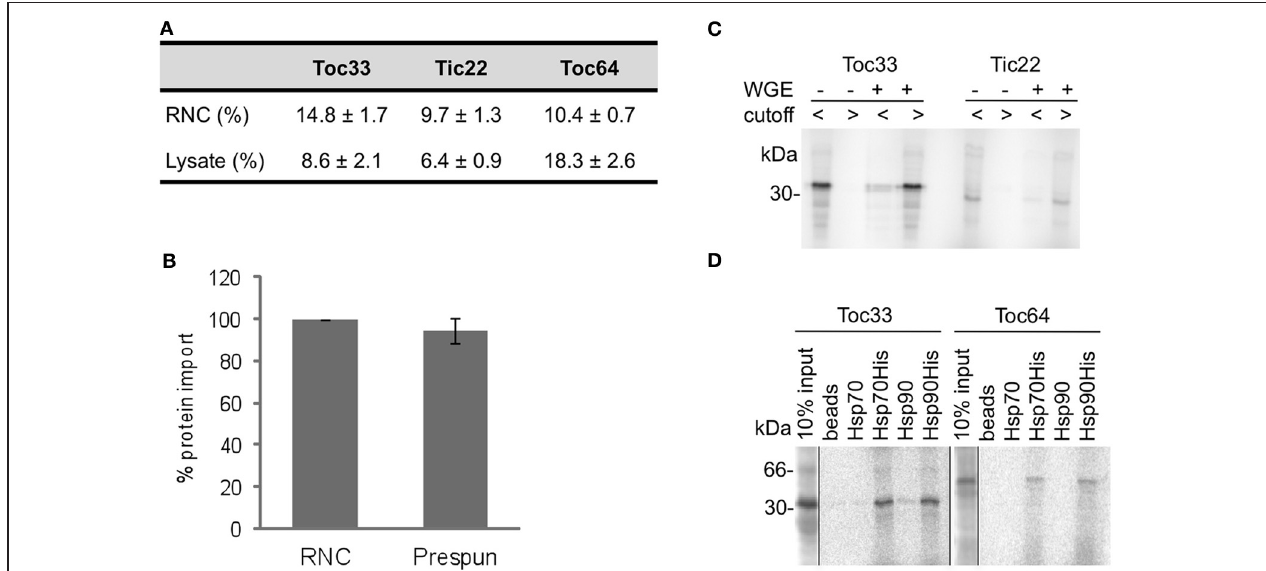
FIGURE 1 | Protein import from RNCs to chloroplasts is efficient and ribosome independent. (A) Radio-labeled proteins (Toc33, Tic22, Toc64), either directly after translation in lysate or after RNC purification, were incubated with chloroplasts, and their import efficiency calculated as a percentage of the total protein input. Mean and standard error are shown ( n = 3). (B) Toc64 was imported into chloroplasts with (RNC) or without (prespun) ribosomes present. Toc64 import was normalized to the RNC import, and mean and standard error are shown ( n = 3). (C) Radio-labeled proteins (Toc33 or Tic22) with ( + ) and without ( − ) addition of WGE were